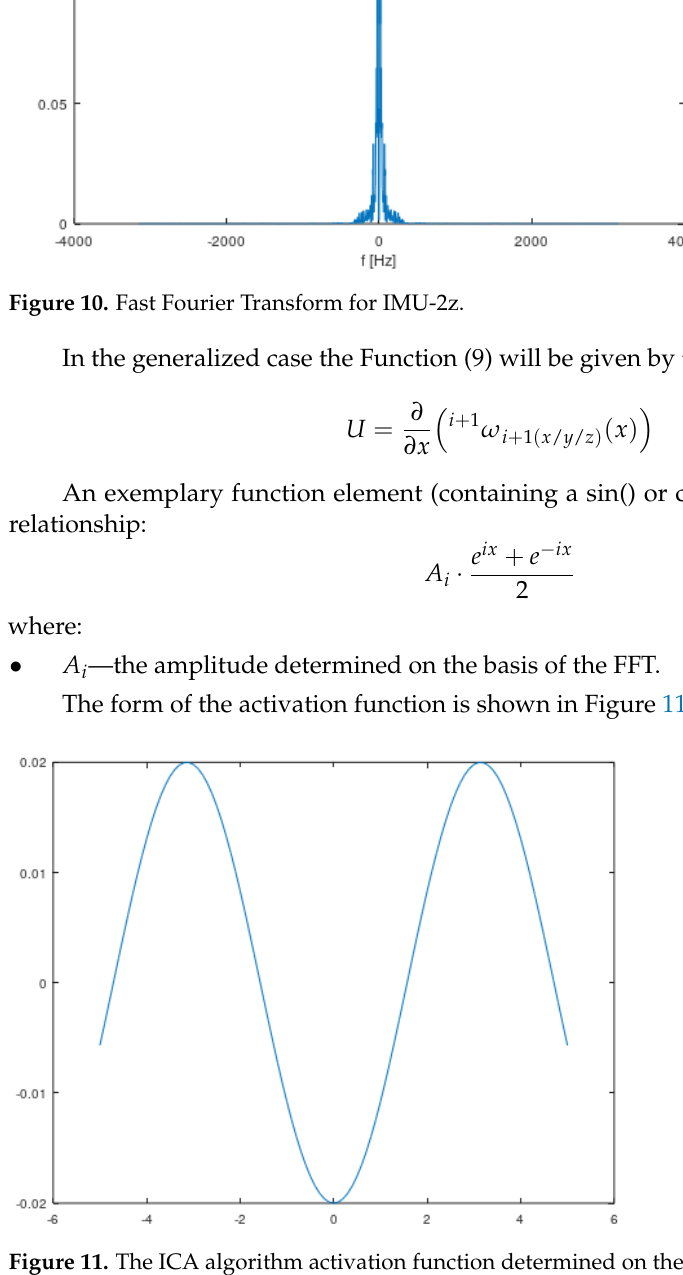
Figure 11. The ICA algorithm activation function determined on the basis of the dependence (9).